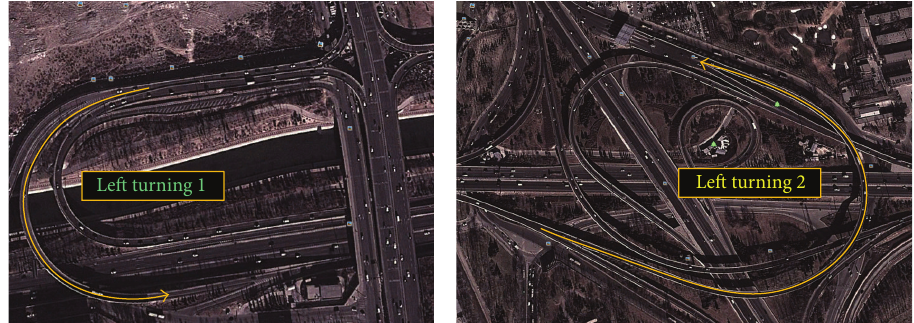
Figure 2: The left-hand bends (map obtained from Google Earth).